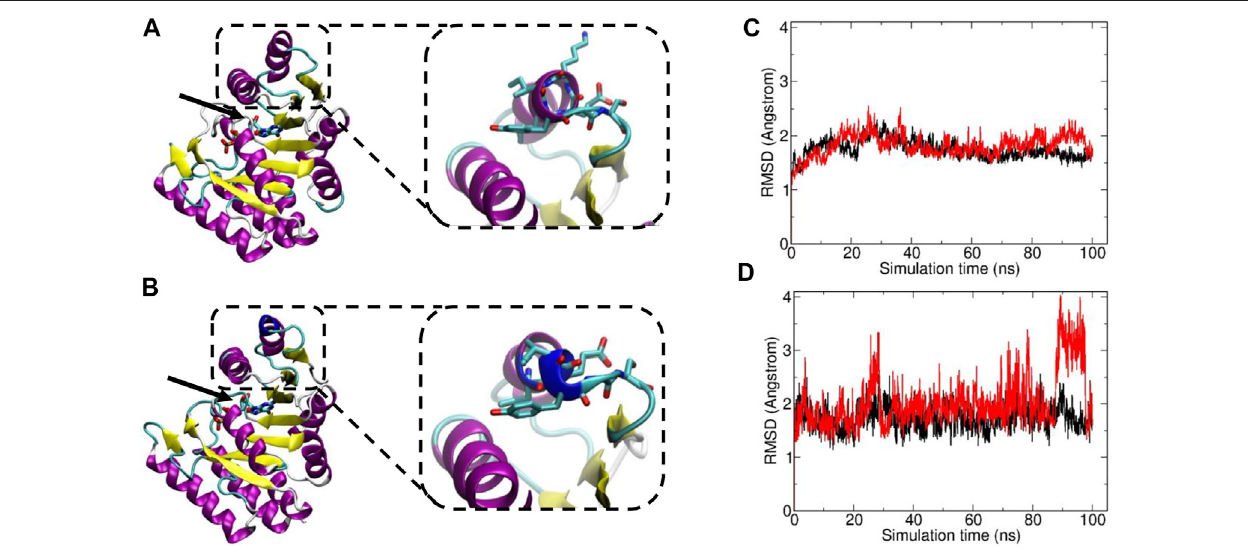
FIGURE 2 | Visualization of Structural Changes of Lys80del in the DPM1 Protein. The DPM1 tertiary structure is shown as color coded cartoon. Alpha helices are colored in pink, beta sheets in yellow, the altered structure near residue 80 in light blue. The location of the GTP/GDP (stick model) is indicated by an arrow. Insets: The location of Lys80 in the one α -helix are highlighted with superimposed amino acids (atom color coded). (A) Structure of wildtype DPM1 protein. (B) Simulation of DPM1proteinharboringtheLys80deletion.Darkblueindicatesthestructuralchangesinthe α -helix. (C) Rootmeansquaredeviation(RMSD)ofthewildtypeDPM1 (black line) and Lys80 deletion (red line) from the start structure vs. simulation time (ns). (D) RMSD vs. simulation time for a segment of ±6 residues around residue 80.